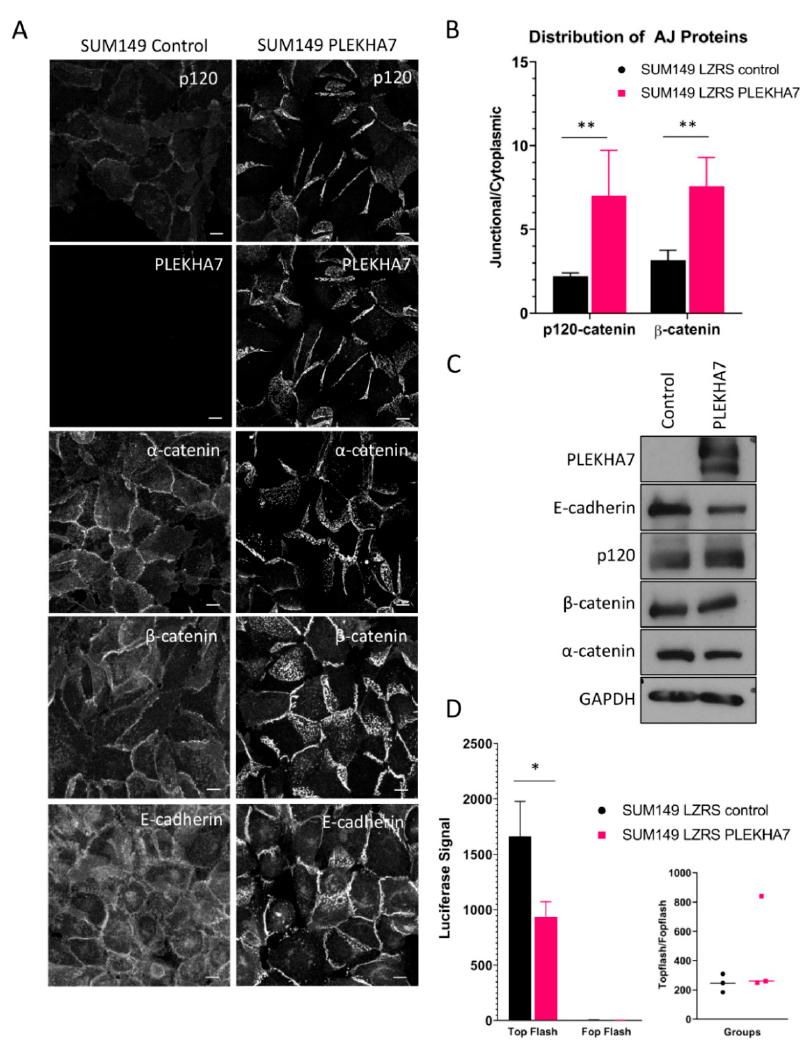
Figure 2. Effect of PLEKHA7 re-expression on SUM149 cell adherens junctions. ( A ) SUM149 cells expressing LZRS ms neo (control) or LZRS PLEKHA7 were grown to confluence and immunofluorescence was performed for E-cadherin, p120-catenin, PLEKHA7, α -catenin, or β -catenin. Images were obtained by confocal microscopy. Images are maximum projection intensity. Scale bar is 10µM. Representative images are shown. ( B ) Intensity of p120-catenin or β -catenin staining is expressed as a ratio of the signal at apical AJs to cytoplasmic staining. N > 75 cells per condition per group. ** indicates p < 0.001, Student’s t -test ( p < 0.0001 for both p120-catenin and β -catenin). ( C ) Protein levels of PLEKHA7, E-cadherin, p120-catenin, β -catenin, and α -catenin in SUM149 LZRS ms neo or SUM149 LZRS PLEKHA7 cells were obtained by Western blot. A representative image is shown. No consistent change was observed for any junctional protein in repeated experiments. ( D ) A representative graph displaying Wnt/ β -catenin signaling in SUM149 LZRS ms neo and SUM149 LZRS PLEKHA7 cell lines using dual luciferase reporter assay. * indicates p < 0.05, Student’s t -test ( p = 0.022).